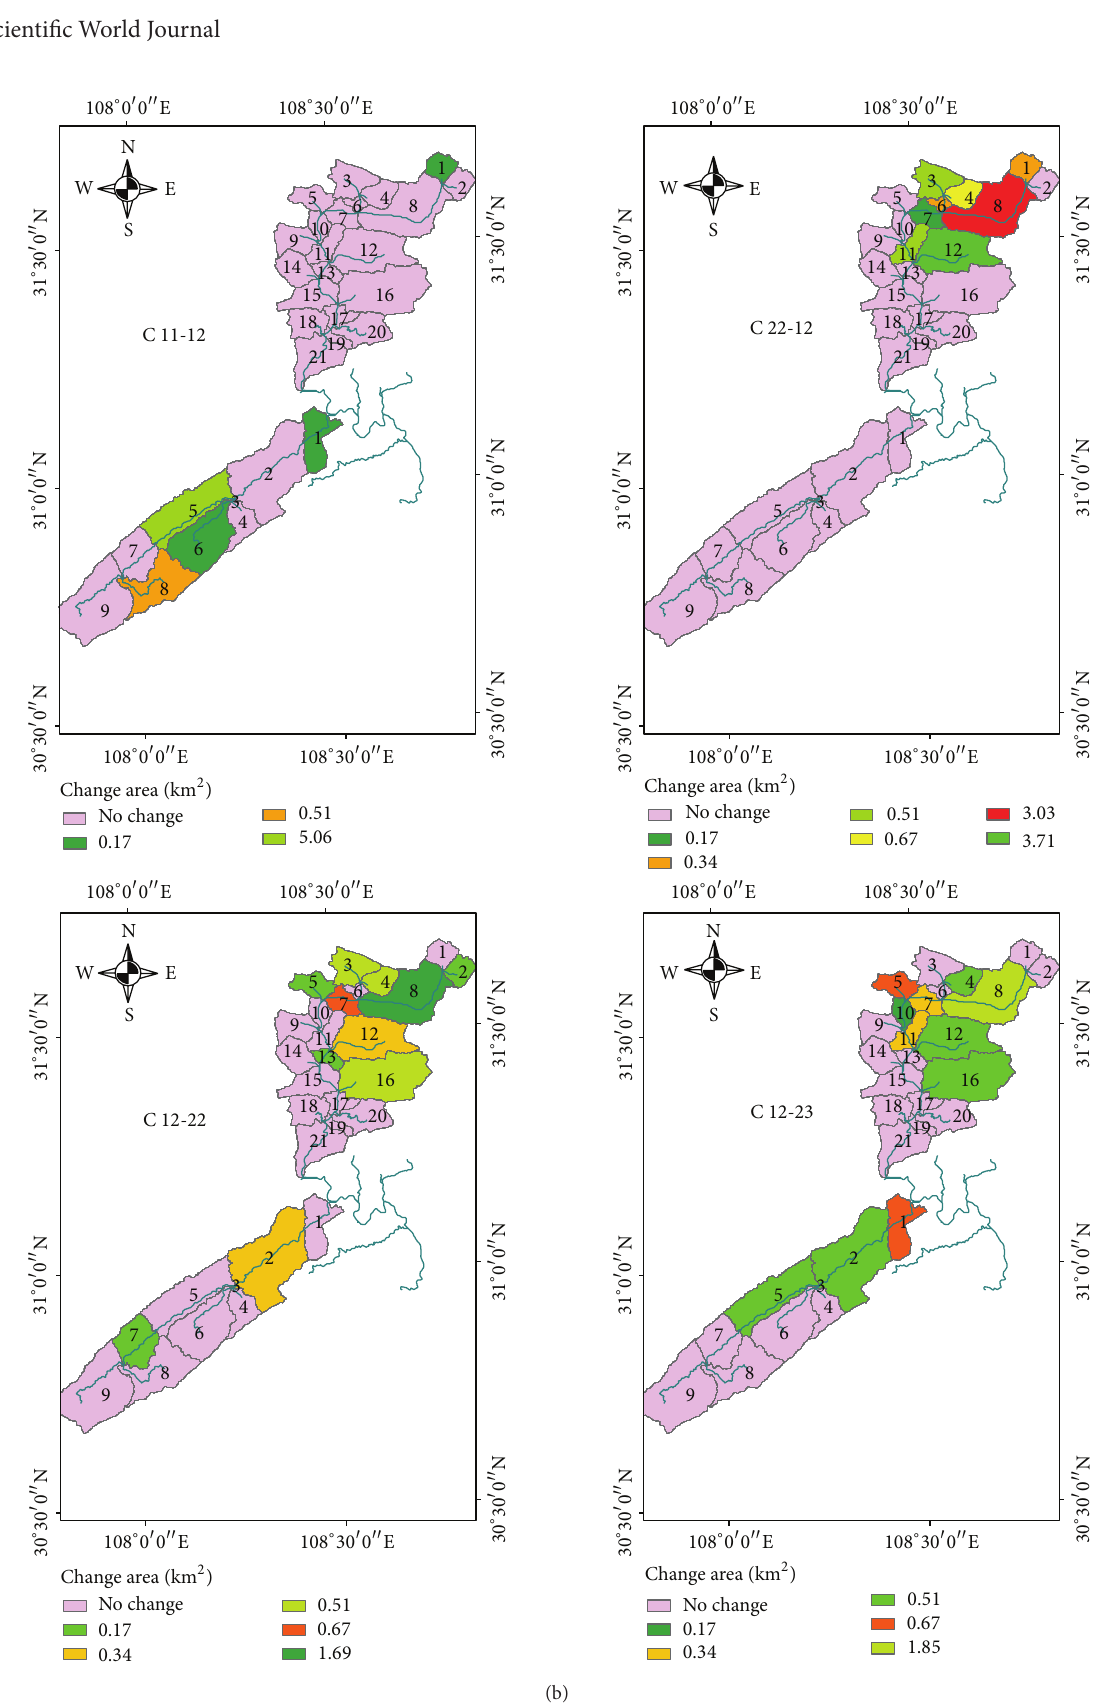
Figure 5: Spatial variation of land use conversion from 2000 to 2010. C12–3 upland to pasture; C3-4 pasture to water; C12–4 upland to water; C3–12 pasture to upland; C11-12 paddy field to upland; C22 – 12 shrubland to upland; C12 – 22 upland to shrubland; C12 – 23 upland to